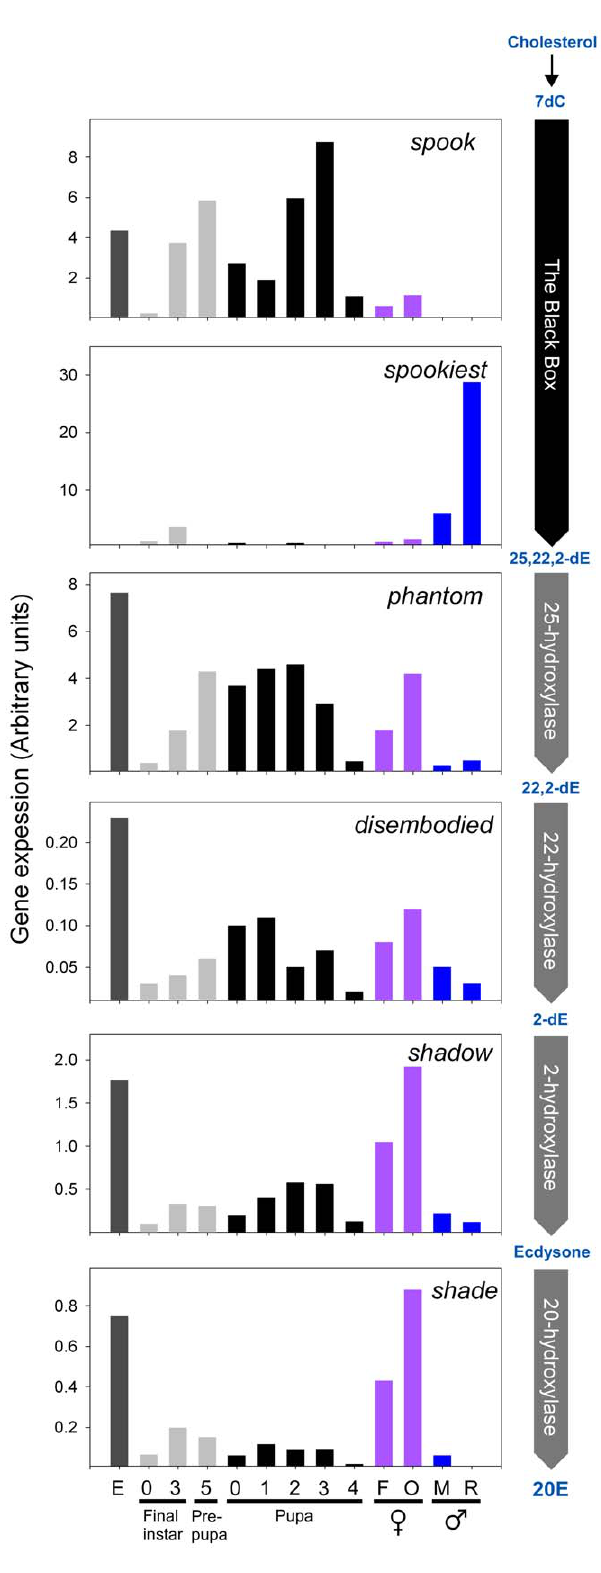
Figure 1. Halloween gene expression during development and in adult Tribolium . The relative mRNA distribution of the Halloween genes during development and in adults was measured by qPCR. Expression was normalized to rpS3 mRNA levels. The step in the ecdysteroid biosynthetic pathway catalyzed by each enzyme is shown on the right. Numbers on the x-axis indicate the day of each stage.